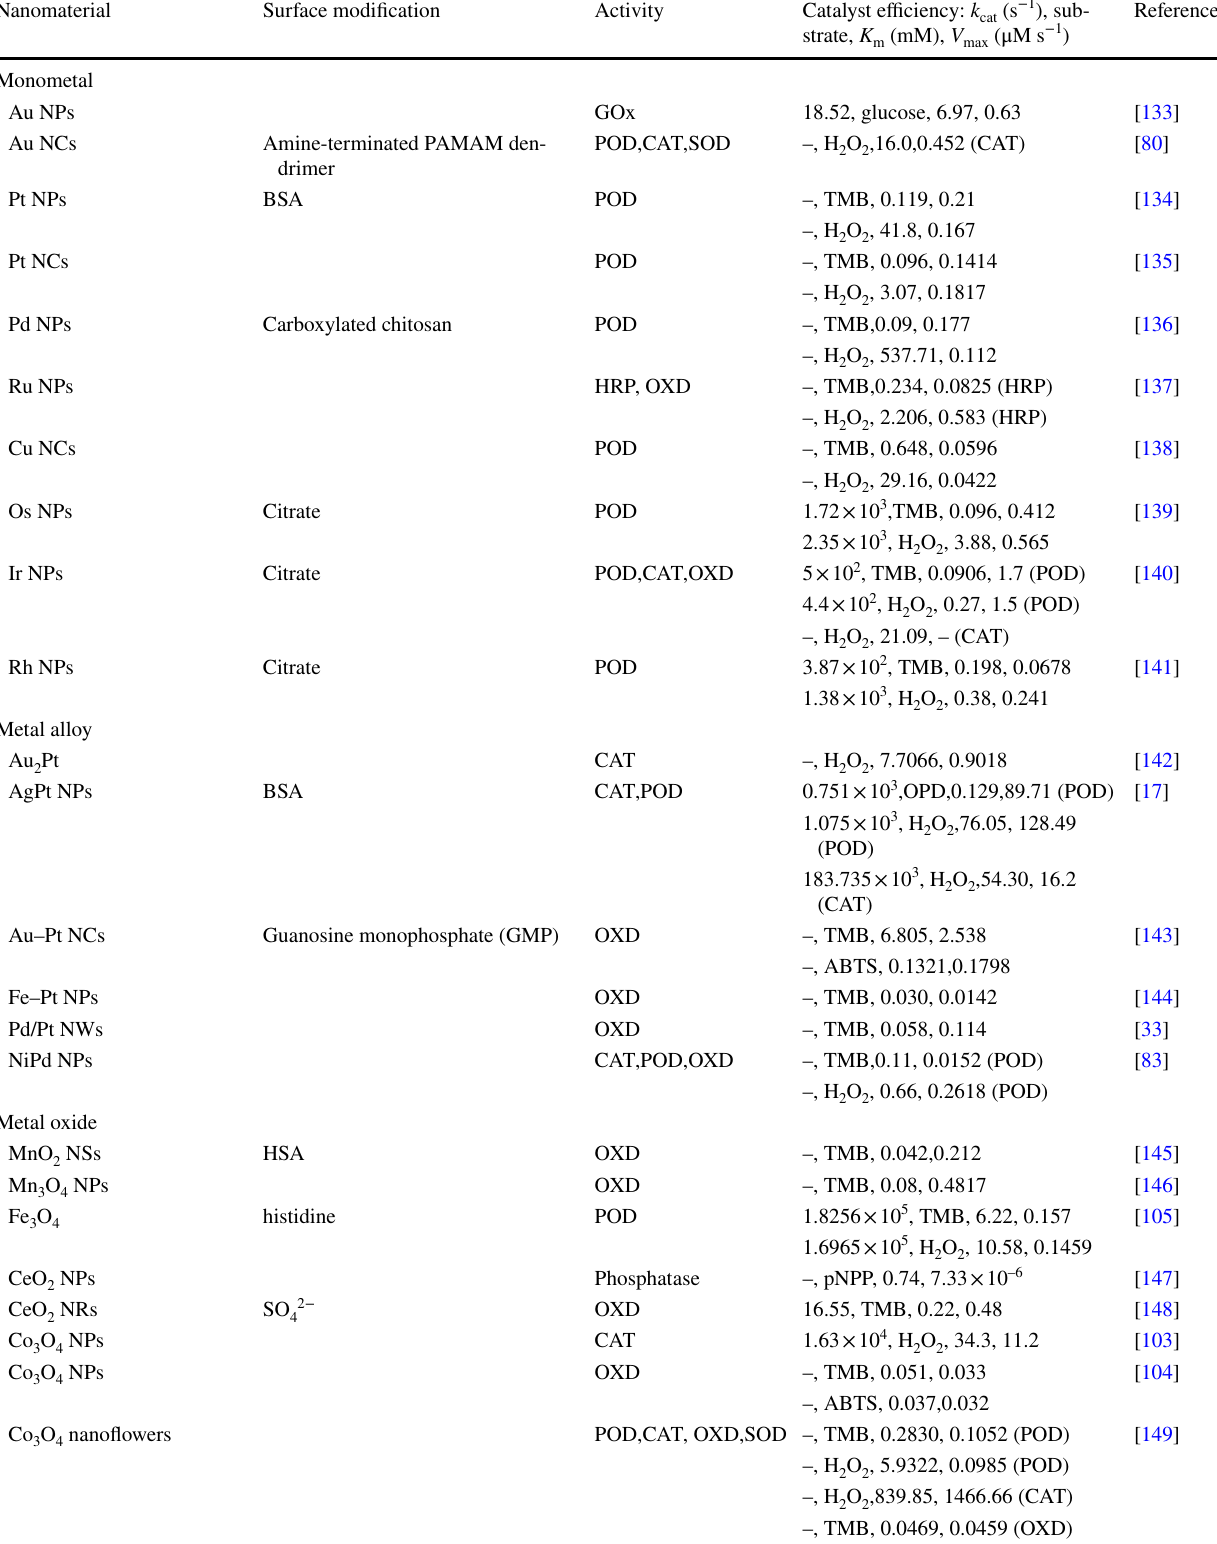
Table 1 Intrinsic activity and catalytic efficiency of typical metal- and metal oxide-based nanozymes